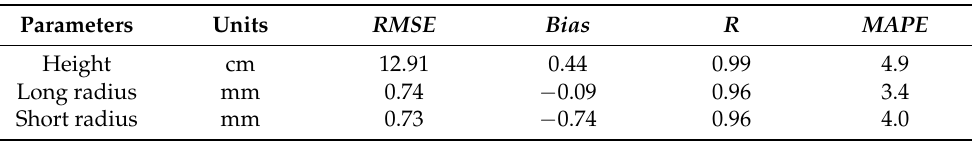
Table 3. The indicators of the simulated maize height and stem radius in the maize canopy parameters compared to the field-measured